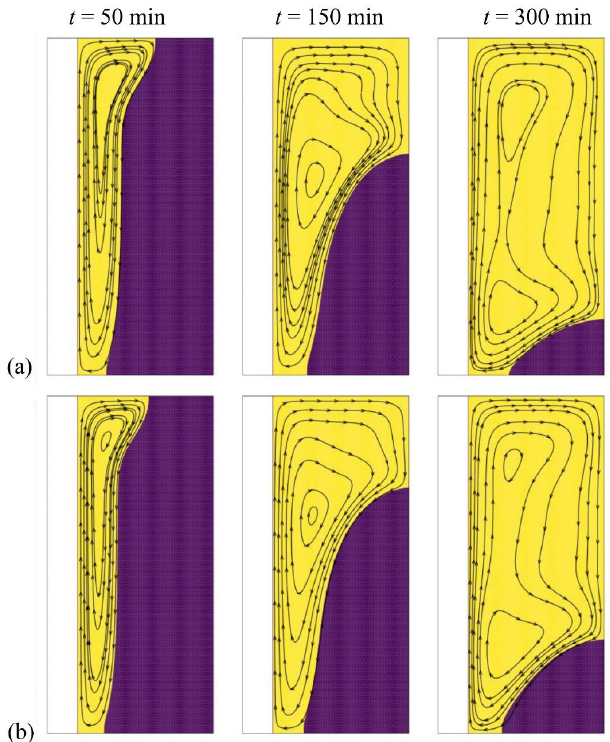
Figure 6. Effect of volume fraction of nanoparticles (ω na ) on the streamlines, ( a ) optimum case with ω na = 0.06; ( b ) Case 1 with ω na = 0, for A = 0 mm.